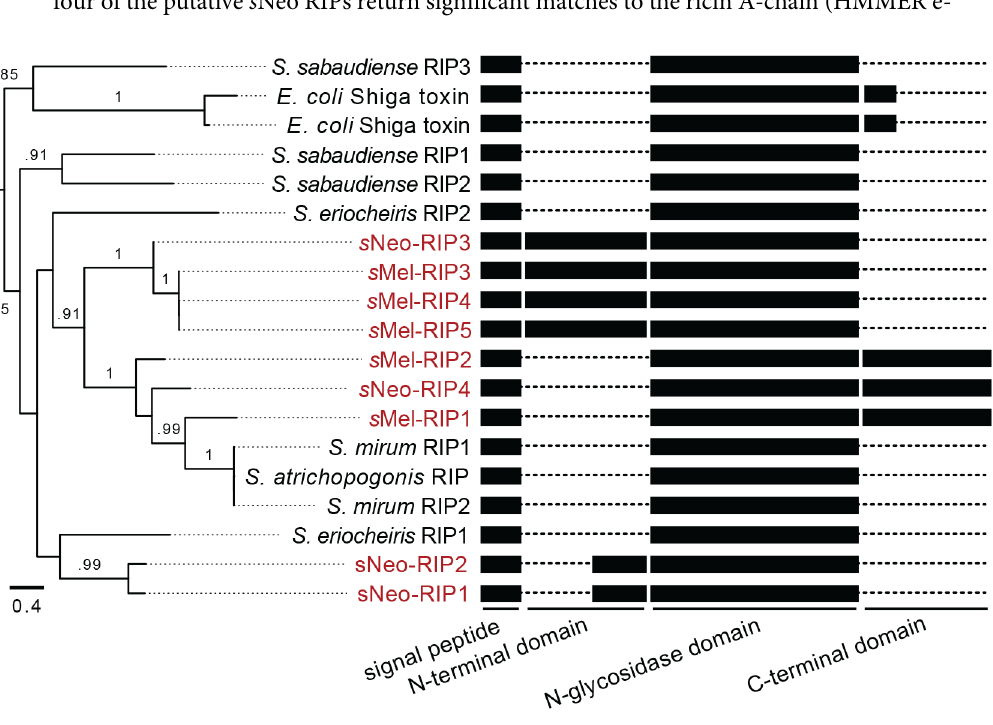
Fig 4. Diversity of ribosome-inactivating proteins in Spiroplasma . A maximum likelihoodphylogram of Spiroplasma ribosome-inactivating proteins(RIPs), alongwith a diagramshowingputative domains. E . coli Shiga toxin is also included. Sequencesfrom defensive Spiroplasmas of Drosophila are shown in red. RIP number designations correspond with the numberingsystem used for RIP transcripts elsewherein the manuscript. Branches are labeledwith approximate likelihood-ratio test scores of .75 or